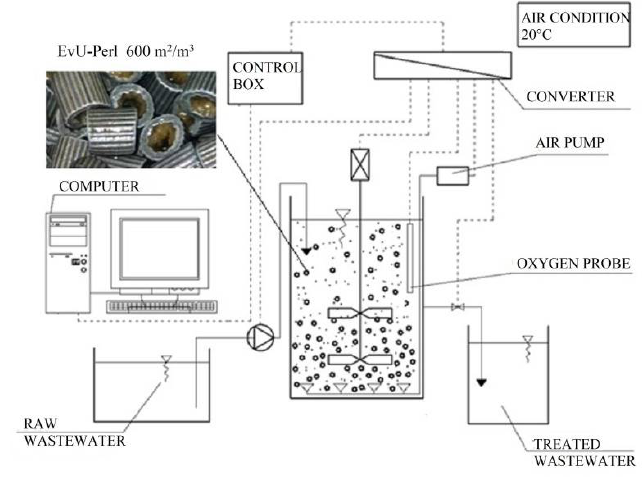
Figure 1. Schematic of reactor with accessories.